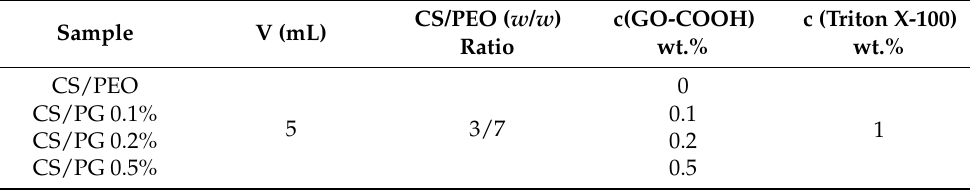
Table 1. The composition of all electrospun